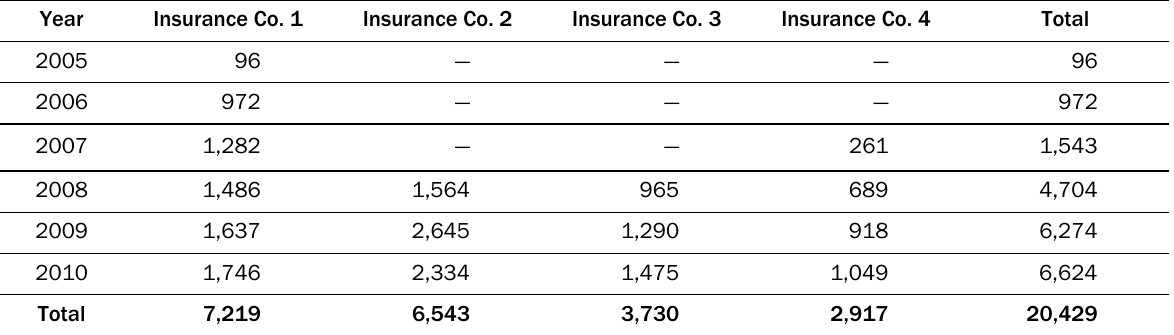
Table 1. Number of CSA Rebates Claimed,